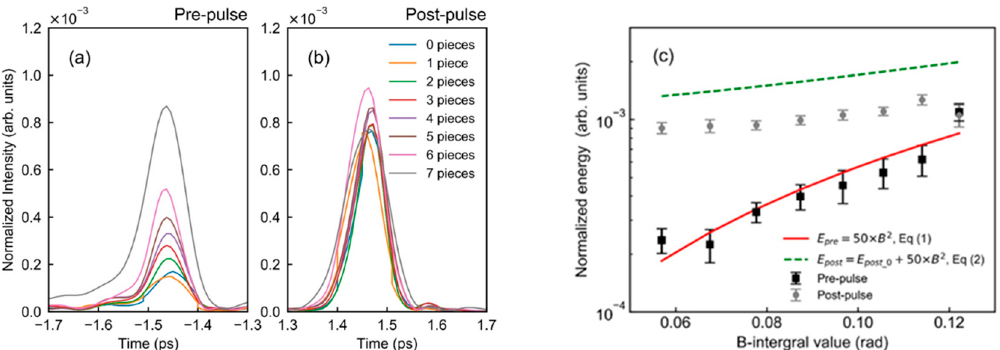
Figure 4. ( a , b ) Temporal contrast for the pre- and post-pulses and ( c ) normalized energy of pre- and post-pulses with the addition of a glass sheet at a laser energy of 23 mJ. The values in ( a , b ) indicate the number of glass plates. The experimental conditions are listed as No. 3 in Table 1. The solid line indicates the results of the approximate curves with Equation (1). The dashed line indicates the post-pulse energy of Equation (2).